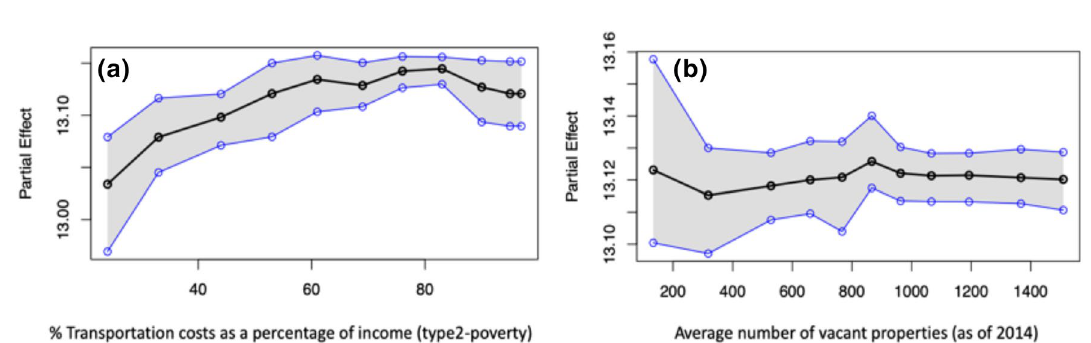
Figure 2. Partial Dependence Plots (PDPs) of the key physical aspects of the built environment: ( a ) % of the transportation cost as a percentage of income and ( b ) average number of vacant properties. In each sub-figure, on the x - axis , the values of the particular independent variable is plotted, and on the y - axis , the partial effect of the independent variable on the response variable is depicted. The black curve is the average partial effect of the predictor variable and blue lines indicate the 95% confidence